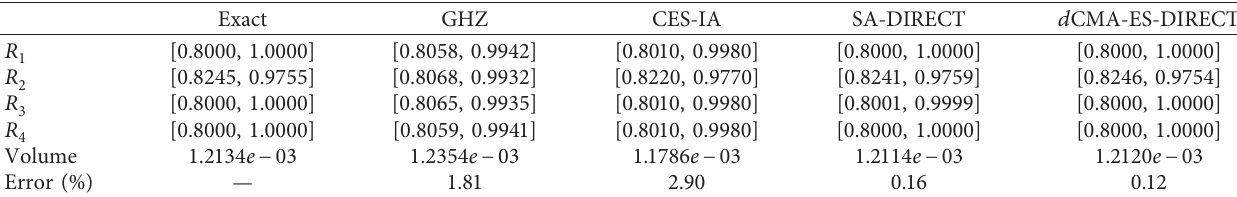
Table 3: Comparison I: the exact, GHZ, CES-IA, SA-DIRECT, and d CMA-ES-DIRECT solutions. Exact